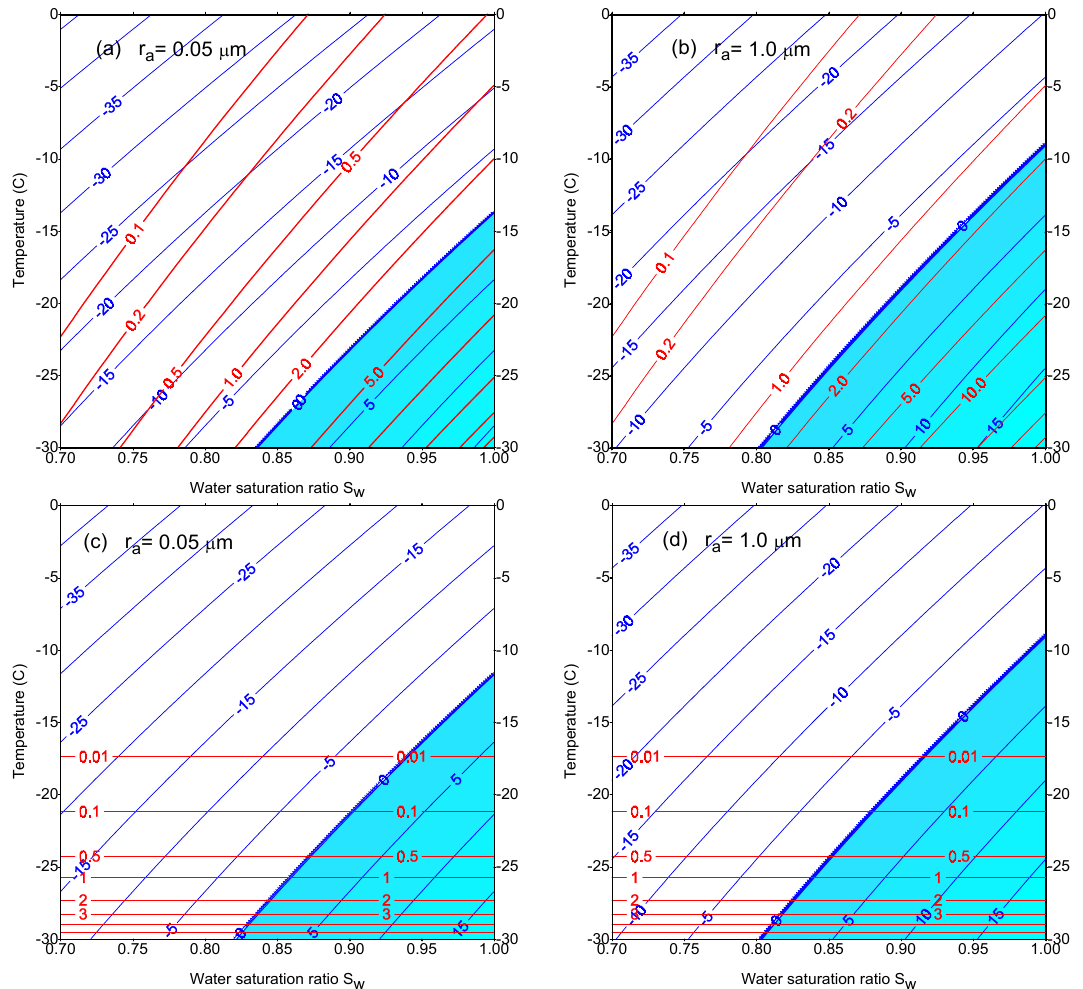
Fig. 1. S w − T diagrams of N c calculated with MDC92 (a, b) , Eq. (1) here, and DM98 (c, d) , Eq. (3) here, parameterizations (red lines and labels) with superimposed threshold difference δ (RHW th ) = RHW − RHW th = (S w − S w , th ) · 100% (blue lines and labels) calculated denote negative deficit δ ( RHW ). These states Fig. 1. S - T diagrams of N calculated with ,th w c from Eq. (11a) as in KC09. The line δ (RHW th ) = 0 or RHW=RHW th is indicated by deep blue and hatched. The physical states and are thermodynamically prohibited and MDC92 (a, b), Eq. (1) here, and DM98 (c, d), N c above this line (white) are below the critical humidity, S i < S i , cr , and blue isolines denote negative deficit δ (RHW th ) . These states correspond to the negative critical radii, r < 0 Eq. (3) here, parameterizations (red lines and cr are thermodynamically prohibited and correspond to the negative critical radii, r cr < 0 and negative (reverse) difference 1µ of chemical and negative (reverse) difference ∆µ of labels) with superimposed threshold difference potentials, µ ustab < µ stab . Only the states below the blue hatched line RHW − RHW th = 0 (blue filled field) correspond to r cr > 0, 1µ > 0 chemical potentials, µ < µ . Only the ) = RHW - RHW = ( S - S ) × 100 δ ( RHW and are thermodynamically ustab stab ,th ,th w w,th states below the blue hatched line RHW - % (blue lines and labels) calculated from Eq. RHW = 0 (blue filled field) correspond to r (11a) as in KC09. The line δ ( RHW ) = 0 or ,th cr ,th > 0, ∆µ >0 and are thermodynamically RHW = RHW is indicated by deep blue and th allowed. hatched. The physical states and N above this c line (white) are below the critical humidity, S < S , and blue isolines i i,cr